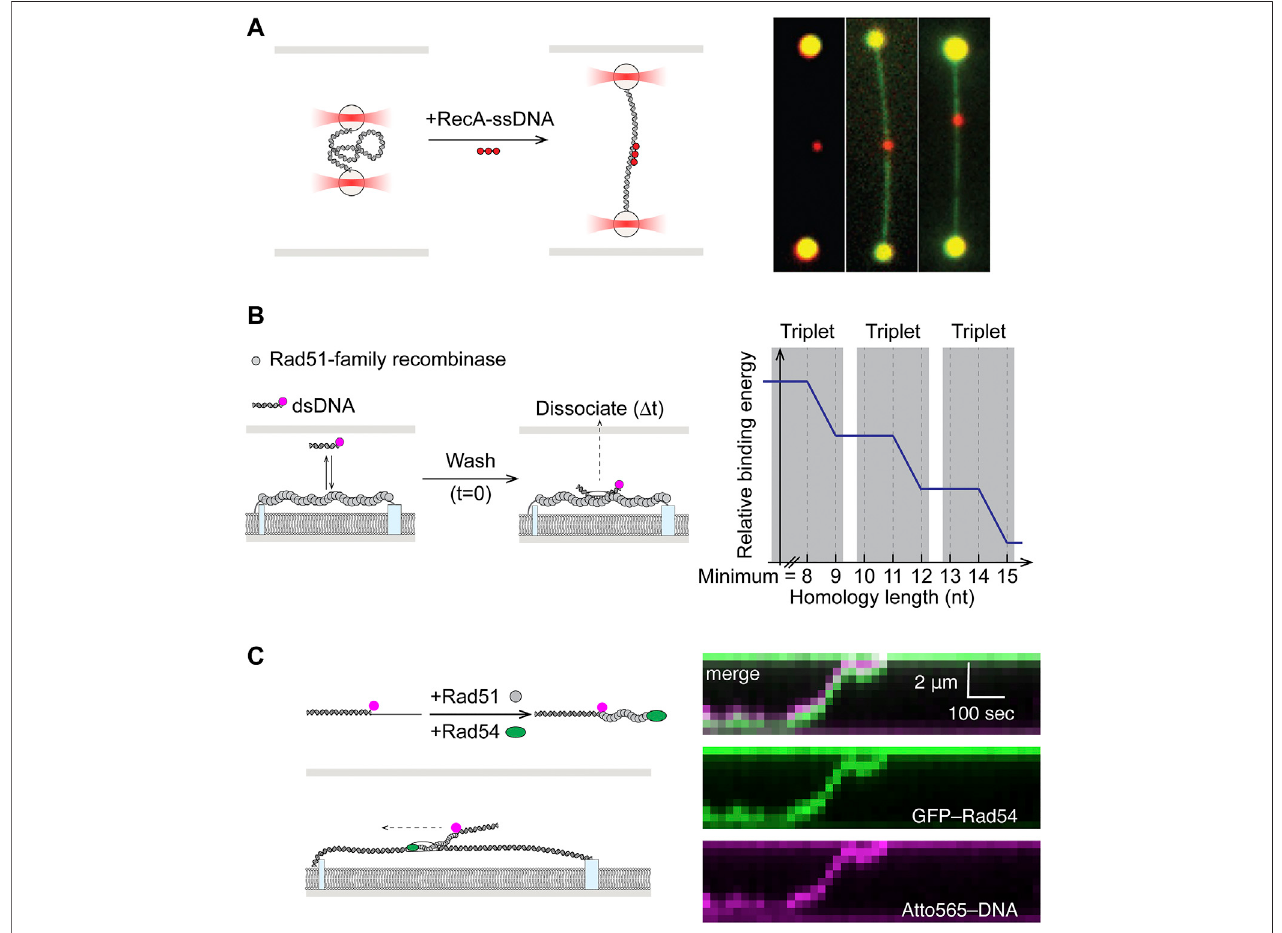
FIGURE 5 | Single-molecule studies of homology search in HR. (A) Left: Dual optical trap setup allowed precise control of dsDNA end-to-end distancein study of homology search by RecA. Right: Fluorescent RecA-ssDNA bound to expected homology positions in dsDNA after incubation. dsDNA could be visualized by staining with YOYO1. Adapted from Forget and Kowalczykowski (2012). (B) Fluorescently-labeled and microhomology-containing dsDNA fragments were incubated with nucleo fi laments formed by Rad51-family recombinases on ssDNA curtain. Dissociation times of bound-particles post-wash ( Δ t ) showed energy stabilization occurring in steps of Watson-Crick base triplets. (C) Left: Presynaptic complexes were assembled by mixing Rad51 and Rad54 with dye-labeled partial duplex DNA containinghomologyinthessDNAoverhangregion. Right: DualcolorimagingoflabeledDNAandRad54showedthatRad54droveactivehomologysearchalongDNA in an ATP hydrolysis-dependent manner. Adapted from Crickard et al. (2020).